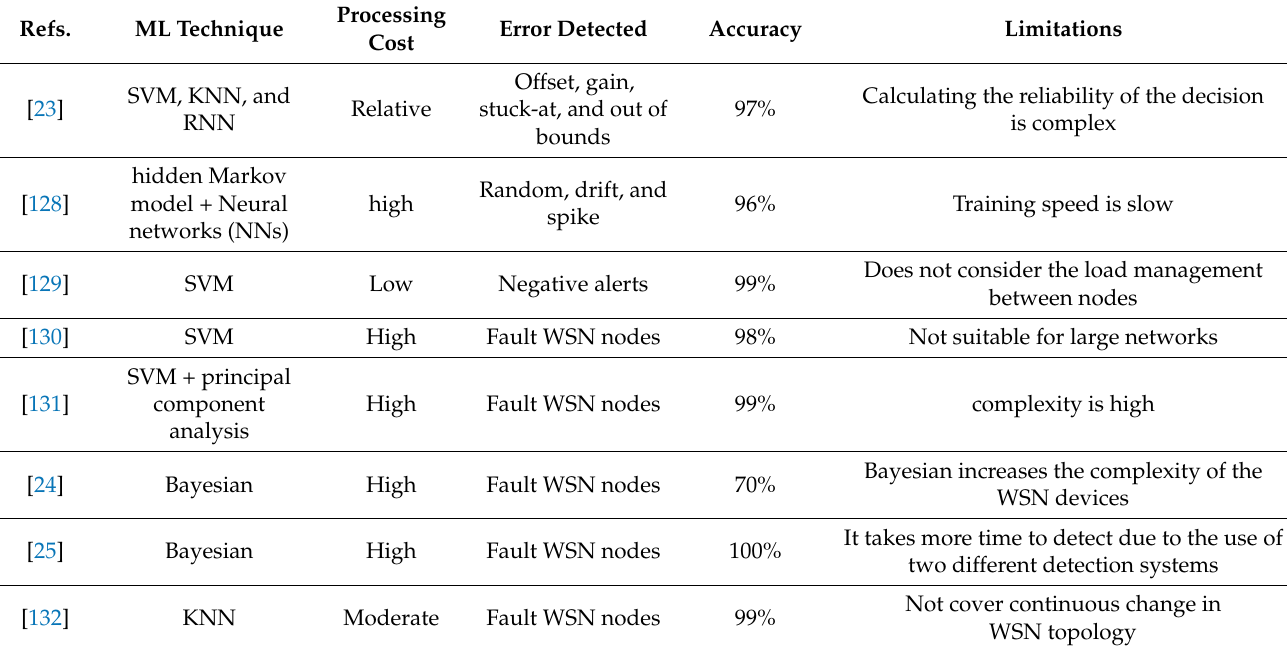
Table 5. Summary of reviewed ML algorithms in error